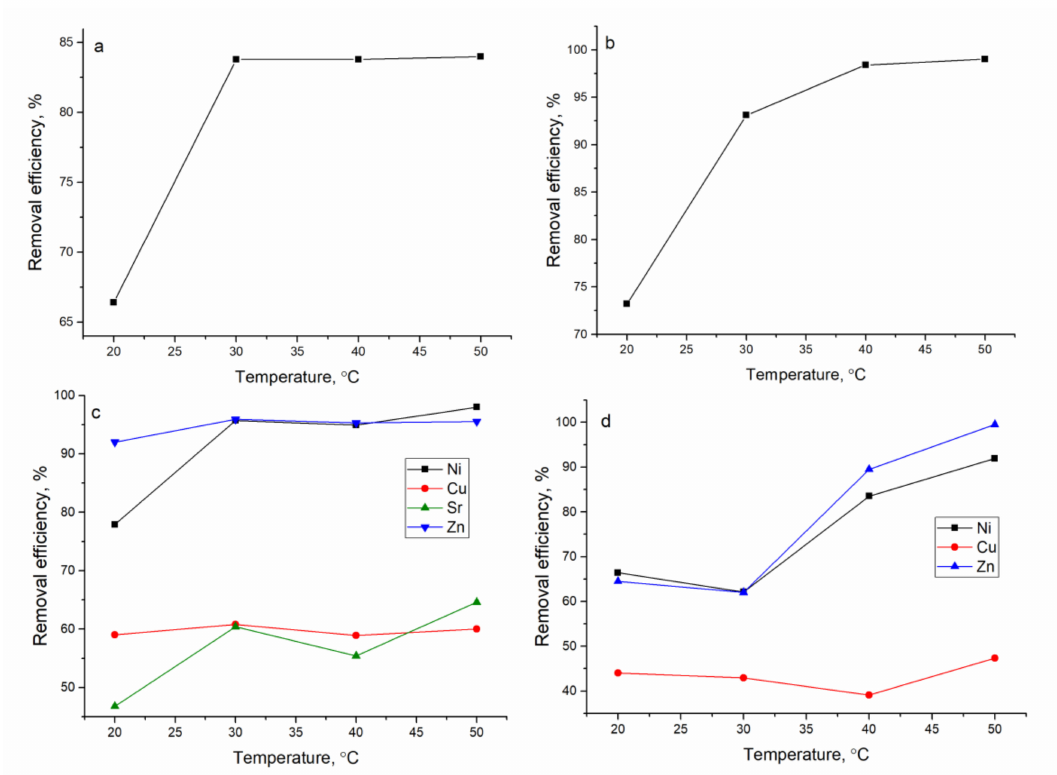
Figure 9. E ff ect of temperature on metal removal by hybrid adsorbent: ( a ) Ni(II), ( b ) Ni(II)-Cr(VI)-Fe(III), ( c ) Ni(II)-Sr(II)-Cu(II)-Zn(II), and ( d )